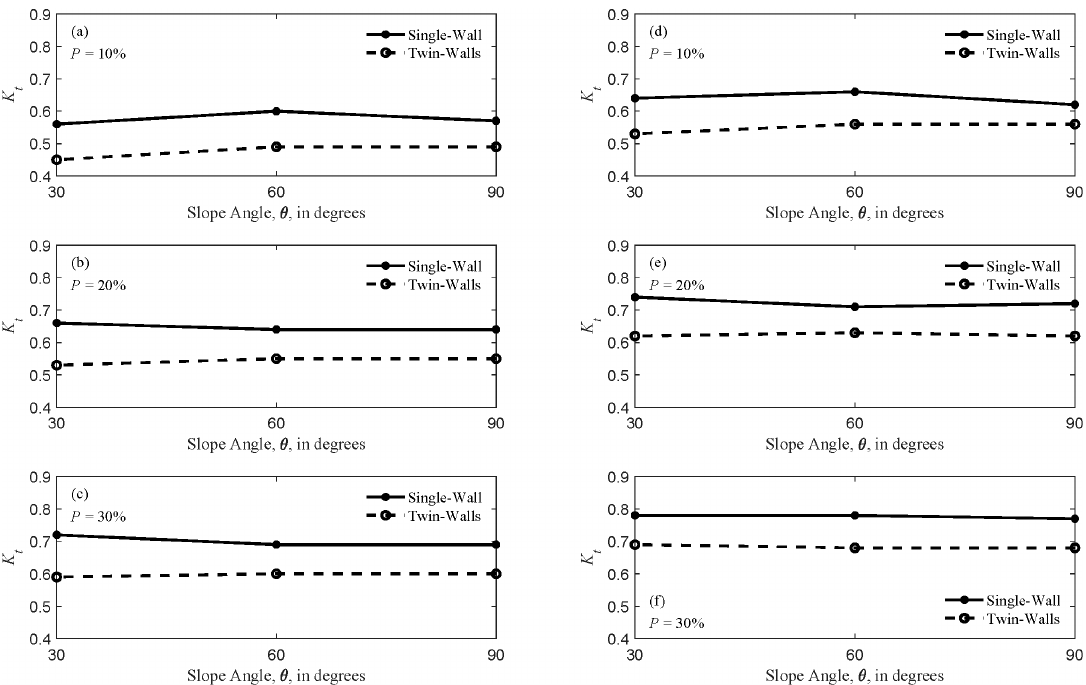
Figure 7. Variation of K t with θ for d / L p = 0.1083 and different porosities and wall configurations. On the left, H is / d = 0.2493 ( a , b , and c ) and on the right H is / d = 0.1284 ( d , e , and f ).